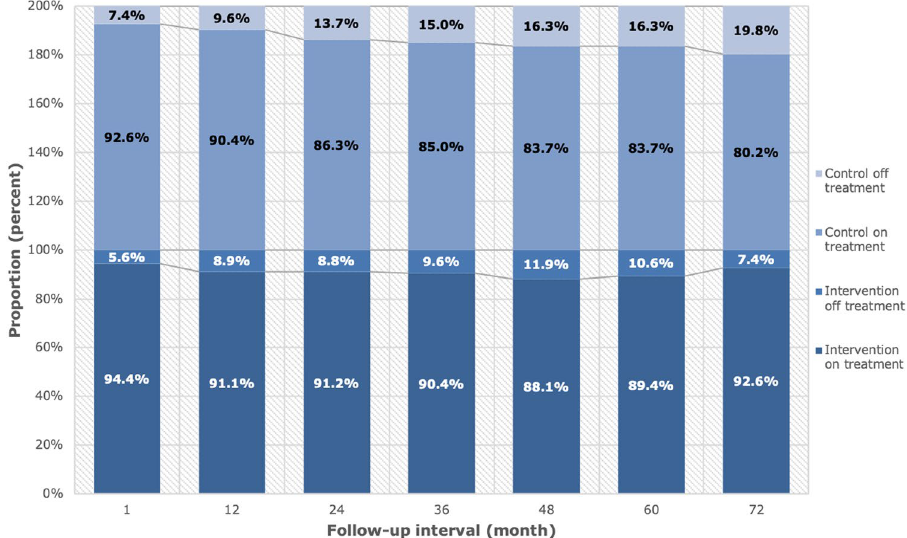
Figure 2. Adherence at each assessment interval.